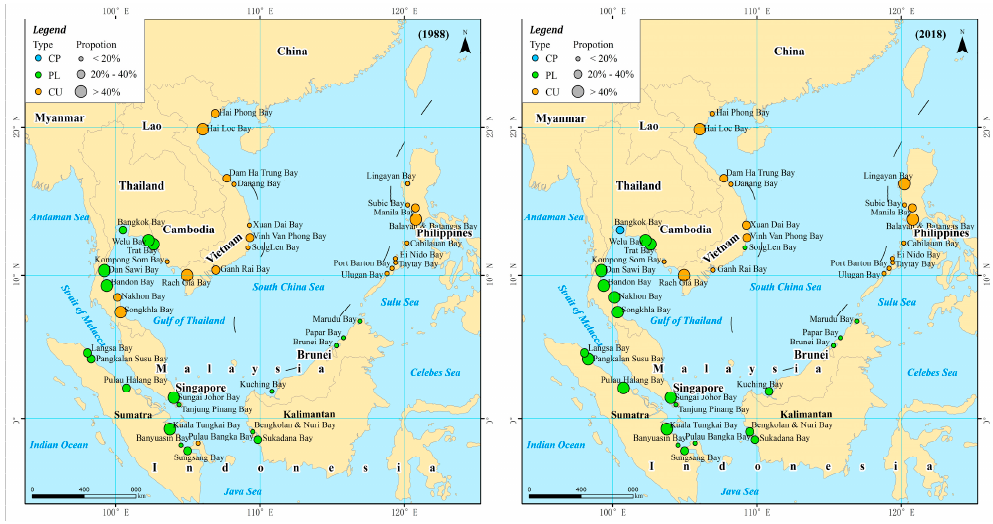
Figure 8. Type and percentage of agricultural land in 1988 and